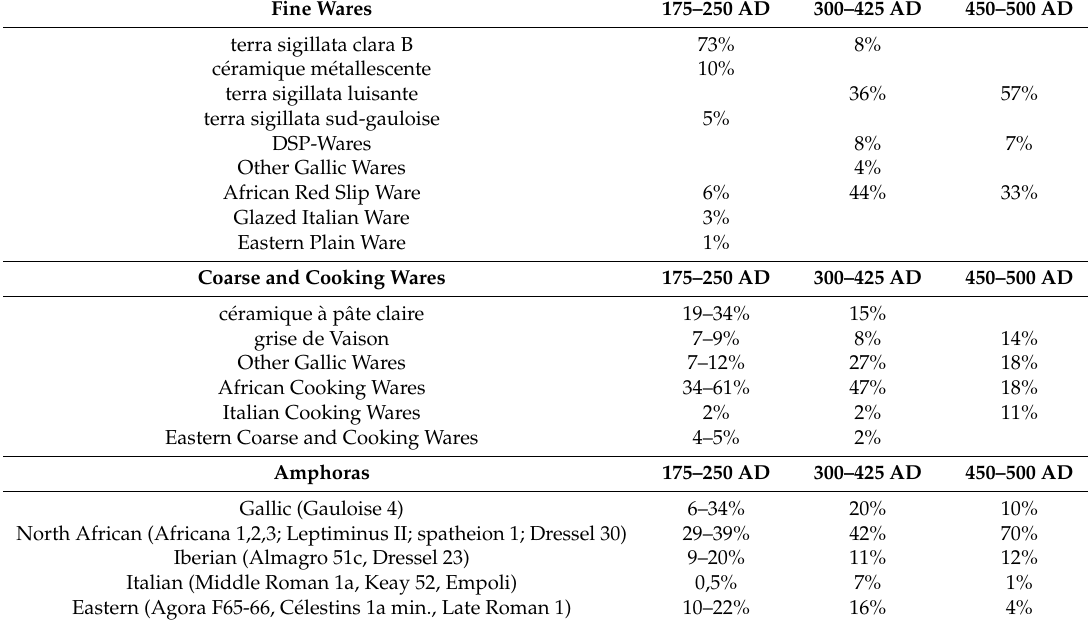
Table A1. Percentages and intervals of percentages of fine wares, coarse wares and amphoras (including the main types) from the port assemblages of Arles. Data from [33] (pp. 76–96, Tables 1–3), [34] (pp. 191–192), [35] (pp. 41–42, Figures 8,9), [36] (pp. 128–132, Tables 1–4), [37] (p. 134, Figure 18).